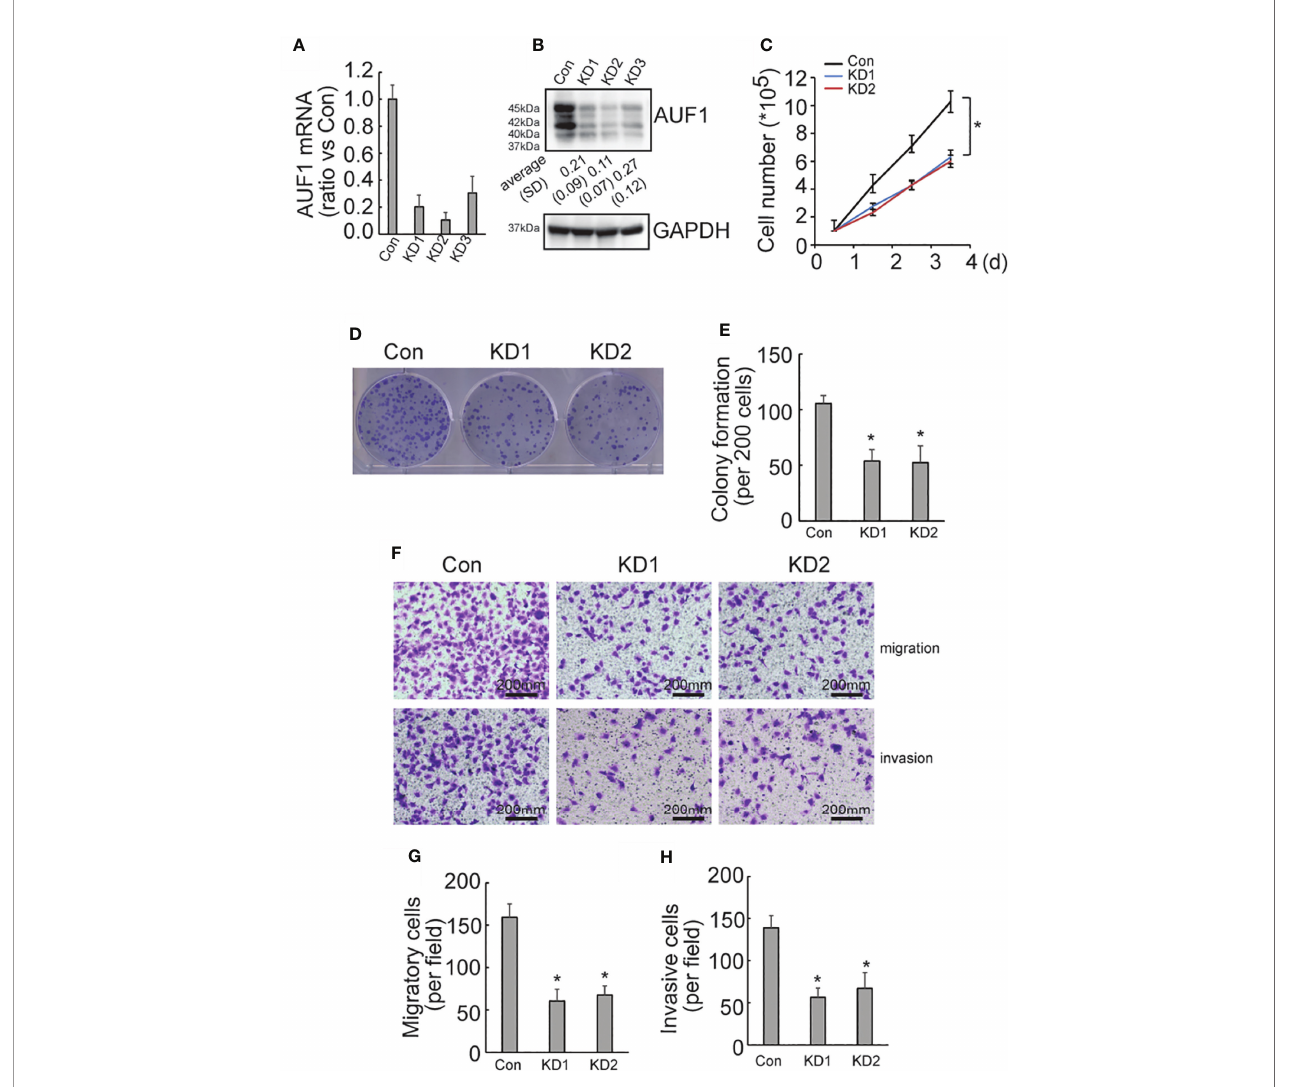
FIGURE 2 | Proliferation, migration, and invasion ability of Con and AUF1-knockdown TPC1 cells. (A) The CRISPR/Cas9 system was applied to knock down AUF1 in TPC1 cells, and Real time PCR was performed to clarify knockdown of AUF1 in thyroid cancer cells; (B) western blot was performed to verify the knockdown ef fi ciency; (C) to evaluate the proliferation ability of TPC1 cells, 1 × 10 5 cells were seeded and counted on day 1 – 4 in both the control group (Con) and AUF1- knockdown groups (KD1 and KD2), n = 3, * P < 0.05; (D) TPC1 cells in Con, KD1, and KD2 groups were seeded separately as single cells with 200 numbers per well in a six-well plate, and a representative photograph of colony formation was presented; (E) the TPC1 colonies were quantitively analyzed by using ImageJ software, n = 3, * P < 0.05; (F) Transwell assay containing Matrigel were applied to observe the migration and invasion ability of TPC1 cells in Con, KD1, and KD2 groups, respectively. The representative photographs under microscope (200 m m) were shown; (G) the numbers of migrated cells in Transwell assay were counted, n = 3, * P < 0.05; (H) the numbers of invading cells in Matrigel containing Transwell assay were counted, n = 3, * P <